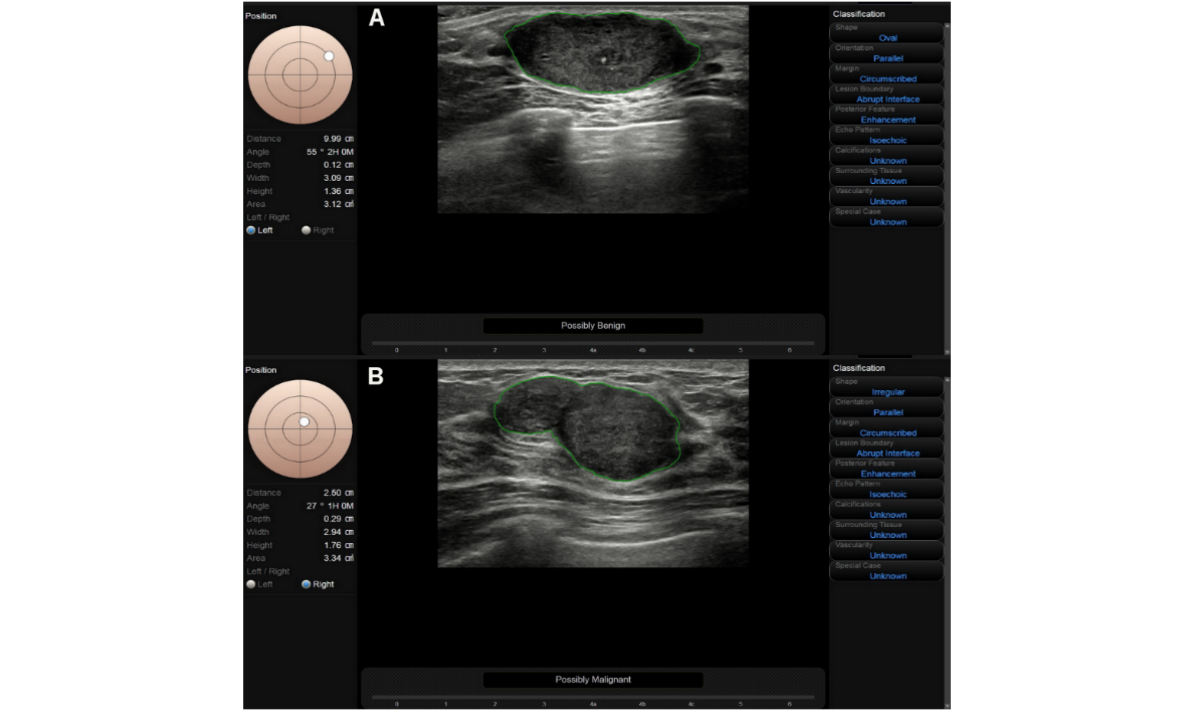
Figure 2. A malignant and benign lesion > 2 cm misdiagnosed by